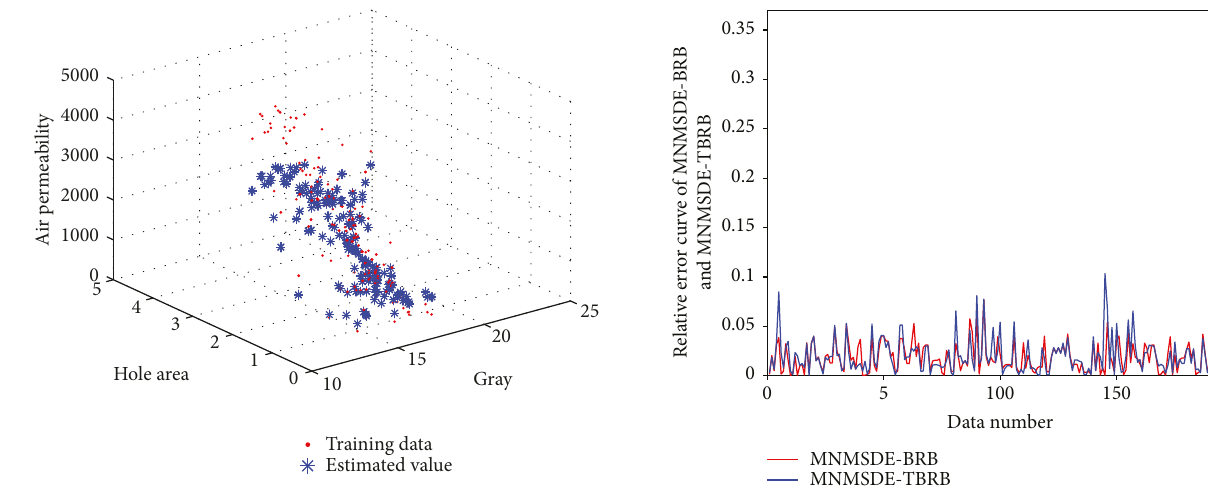
Figure 8: The relative error of MNMSDE-BRB and MNMSDE- TBRB.